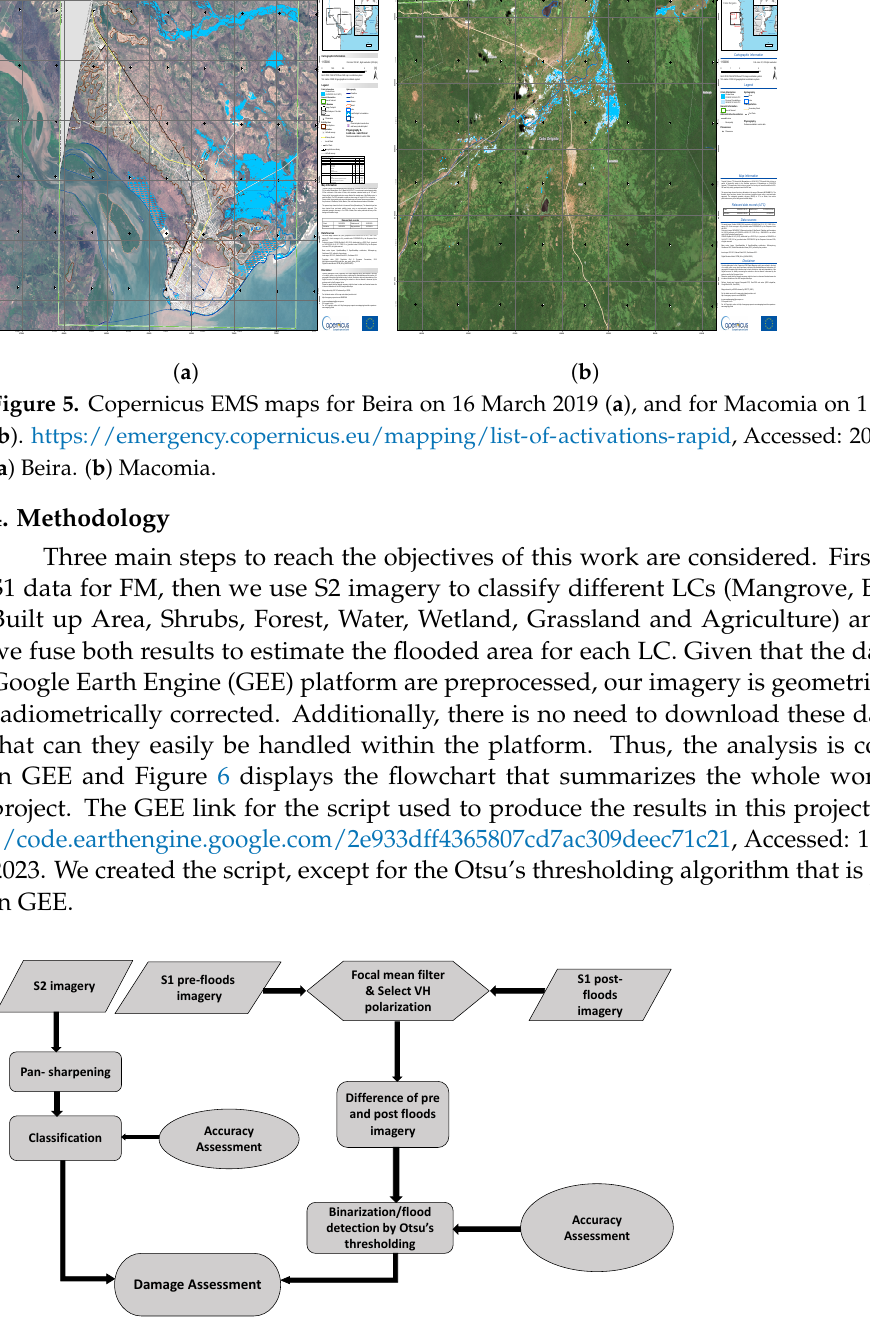
Figure 6. Flowchart summarizing the work in this